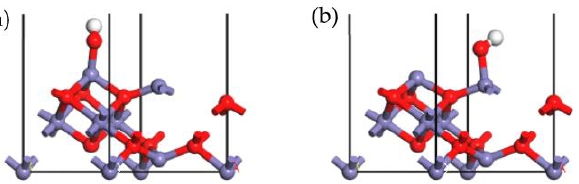
Figure 10. Stable adsorption configurations of -OH onto Fe oct site ( a ), Fe tet site ( b ) of the γ -Fe 2 O 3 (111) surface (Fe, purple; H, white; O, red).